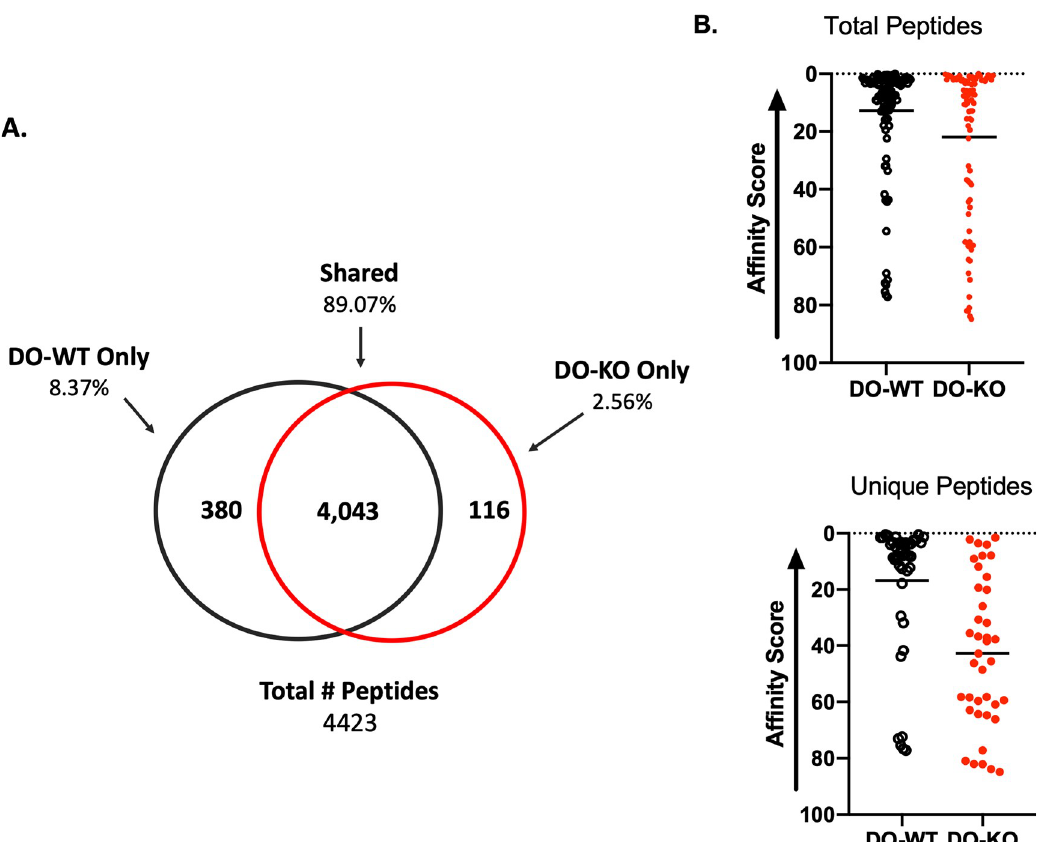
Fig 1. Peptides eluted from I-A b in DO-KO are largely predicted to be poor binders. (A) Breakdown of pooled replicate elution experiments. Sample information was pooled and eluted peptides divided into three categories: (1) peptides only in DO-WT samples, (2) peptides only in DO-KO samples, and (3) peptides shared between both samples. (B) Breakdown of peptides based upon the predicted IEDB affinity score. The closer to zero, the better the predicted affinity (i.e., better binding). Both total peptides (top) and unique peptides (bottom) were subdivided. Line represents the mean score. Data are representative of 2 replicate experiments. Experimental results depicted in this figure can be found in S1 Data. DO, HLA-DO; KO, knockout; IEDB, Immune Epitope Database; WT,